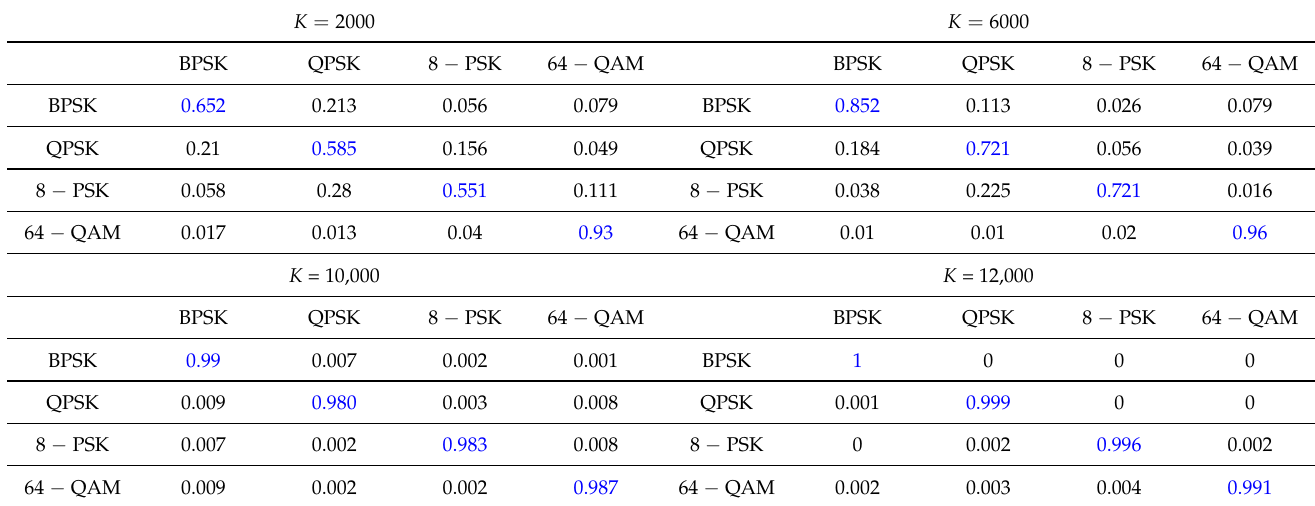
Table 2. Confusion matrices at different number of received symbols, K , at SNR = 15 dB.